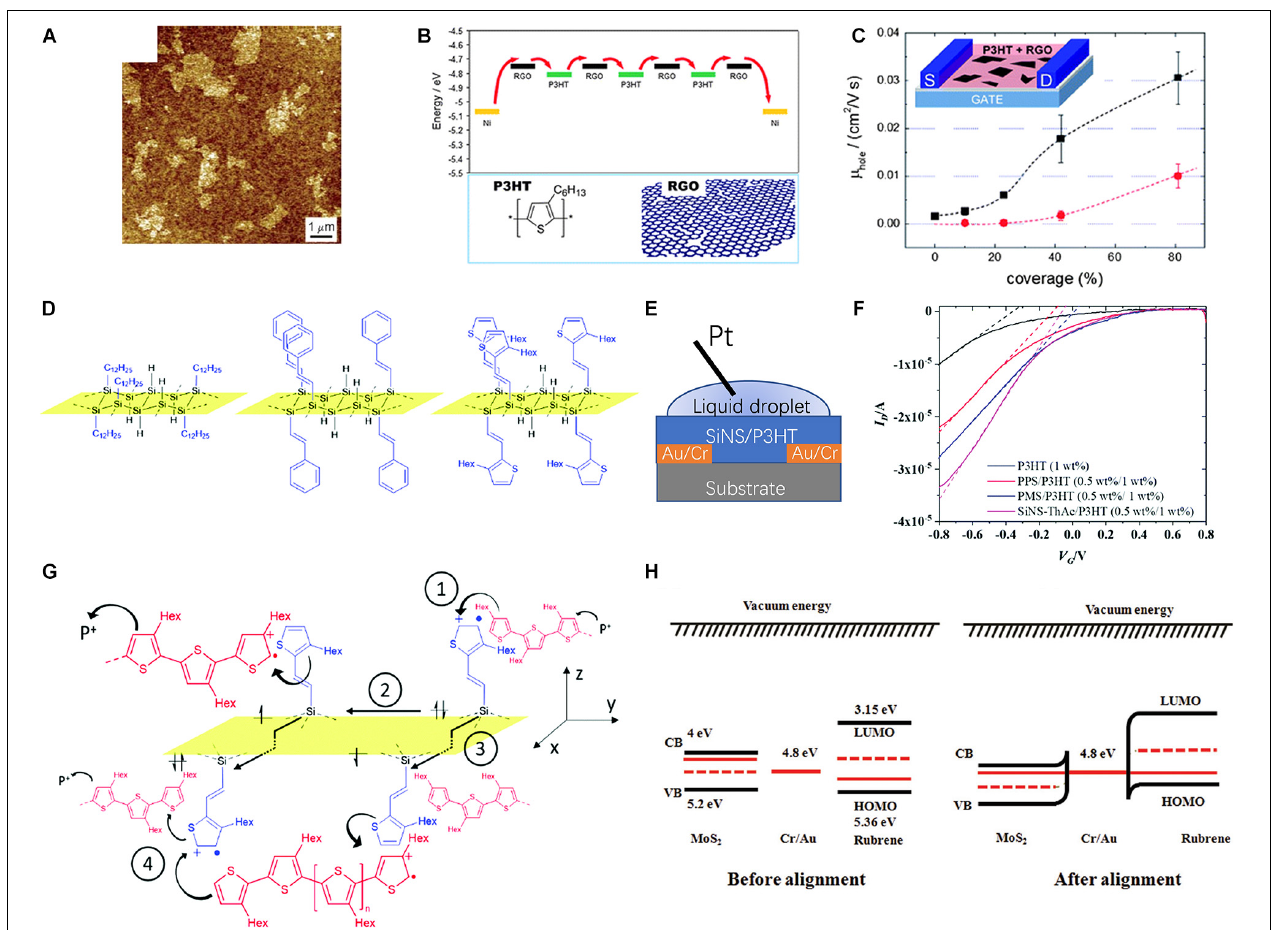
FIGURE 5 | OSCs/2D hybrid FETs with 2D materials as dopants. (A) AFM images of RGO sheets deposited on a native SiO 2 substrate, and covered by a thin film of P3HT. (B) Schematic representation of the energy diagram and charge transport in the device. Inset below shows structures of RGO and P3HT. (C) Hole mobility vs. coverage for RGO and RGO + P3HT FETs. Reproduced from Liscio et al. (2011) with permission from Copyright 2011 the Royal Society of Chemistry. (D) Structures of the SiNSs. (E) EGFET device configuration. (F) the transfer curves (solid lines) and the linear fitting. (G) Possible electronic transportation model in SiNS–ThAc/P3HT hybrid films. Reproduced from Lyuleeva et al. (2018) with permission from Copyright 2018 the Royal Society of Chemistry. (H) Band diagrams of rubrene, MoS 2 , and source–drain electrode before alignment (left) and after alignment (right). Reproduced from Wang and Yan (2010) with permission from Copyright 2017